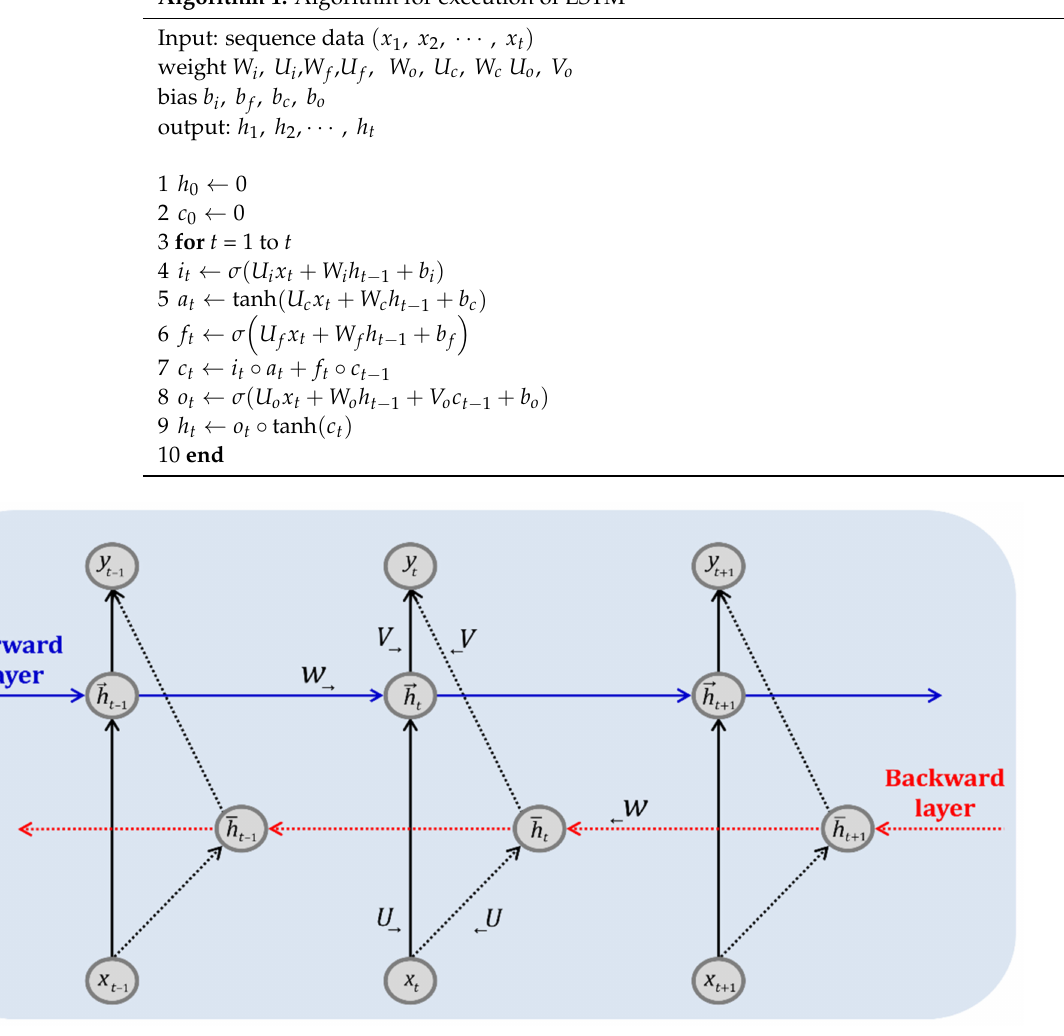
Figure 6. Schematic architecture of the